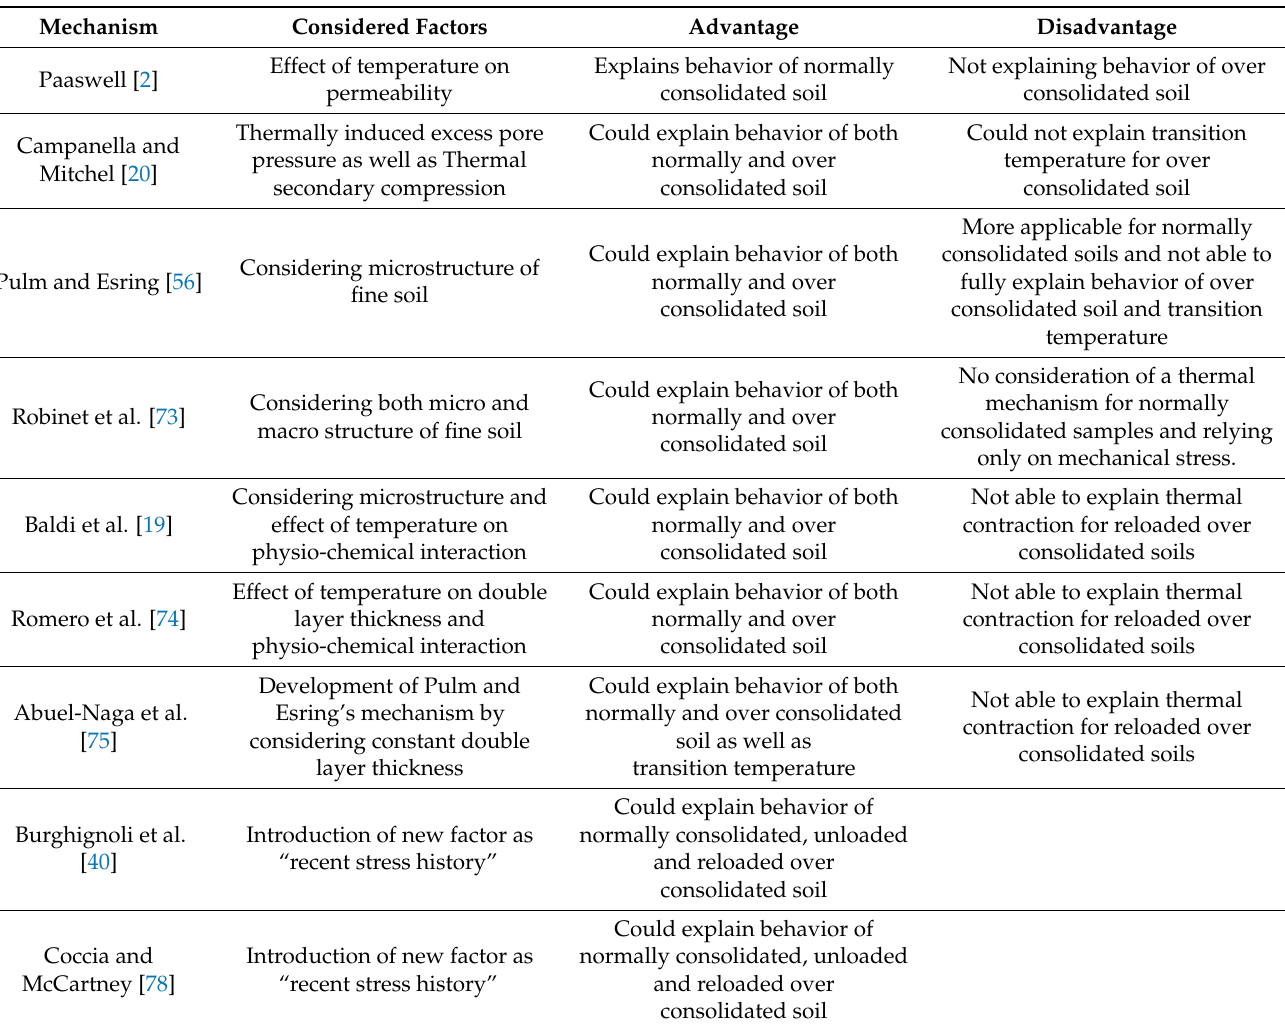
Table 1. Summary of mechanisms for thermally induced volume changes in fine